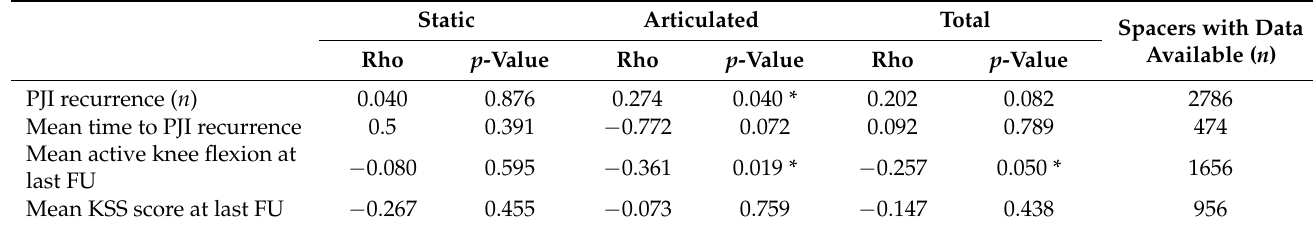
Table 4. Correlations between time to second stage and